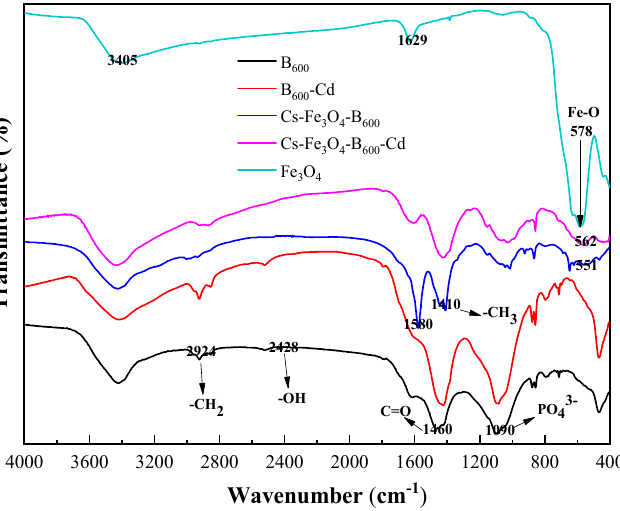
Figure 5. FTIR curves of Fe 3 O 4 , B 600 , B 600 -Cd, Cs-Fe 3 O 4 -B 600 , and Cs-Fe 3 O 4 -B 600 -Cd. The SEM images of Fe 3 O 4 , Cs-Fe 3 O 4 -B 600 , and Cs-Fe 3 O 4 -B 600 -Cd are presented in Figure 6. The Fe 3 O 4 prepared in this experiment has spherical particles with a particle size of